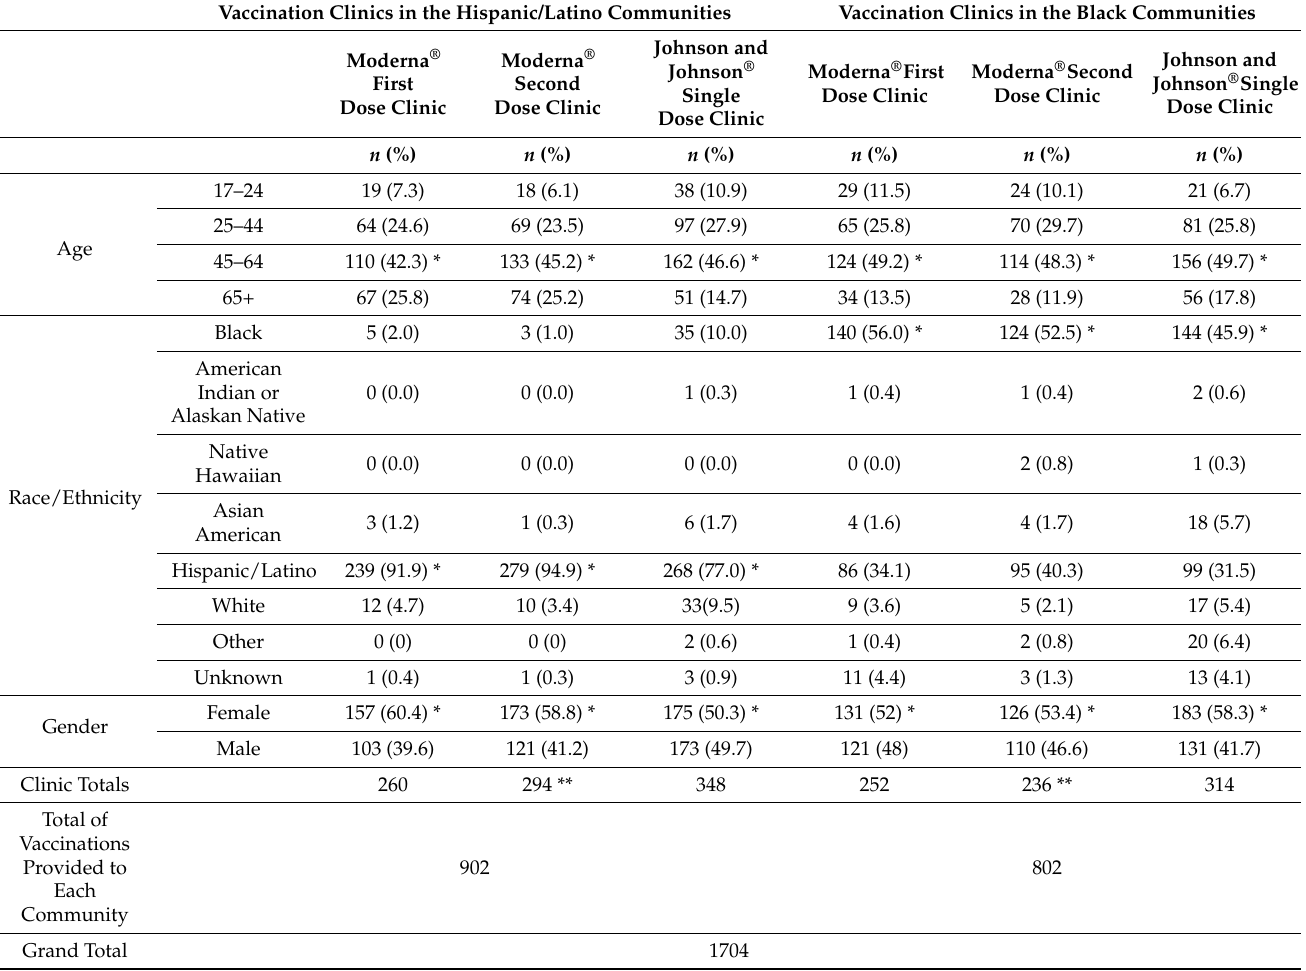
Table 1. Socio-demographic characteristics of community vaccine clinic